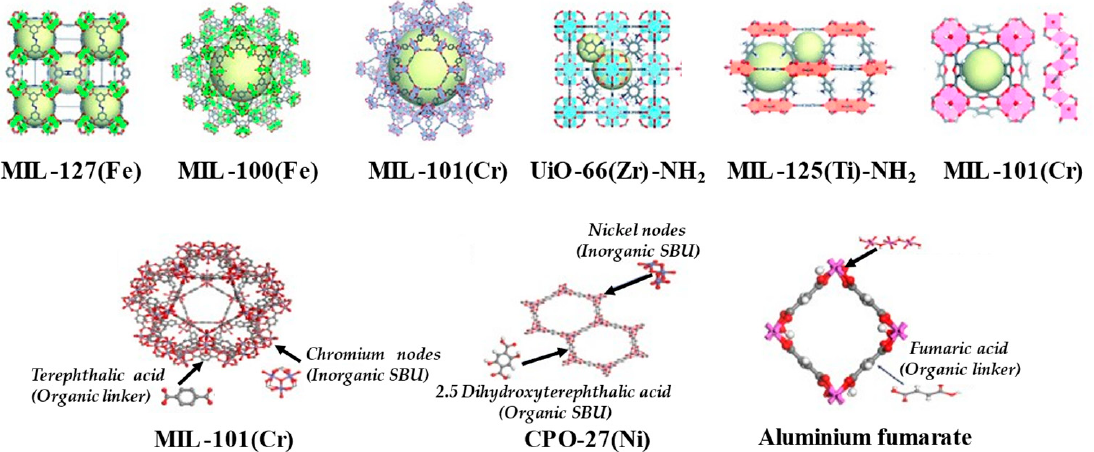
Figure 15. Polyhedral representation of MOFs. The cavity space is indicated by yellow van der Waals spheres (Fe, green; Cr, purple; Zr, blue; Ti, orange; Al, pink; C, gray; N, blue; O, red;